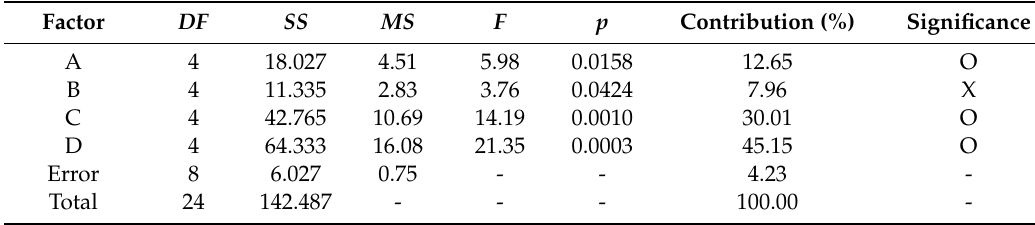
Table 5. Results of ANOVA for flexural